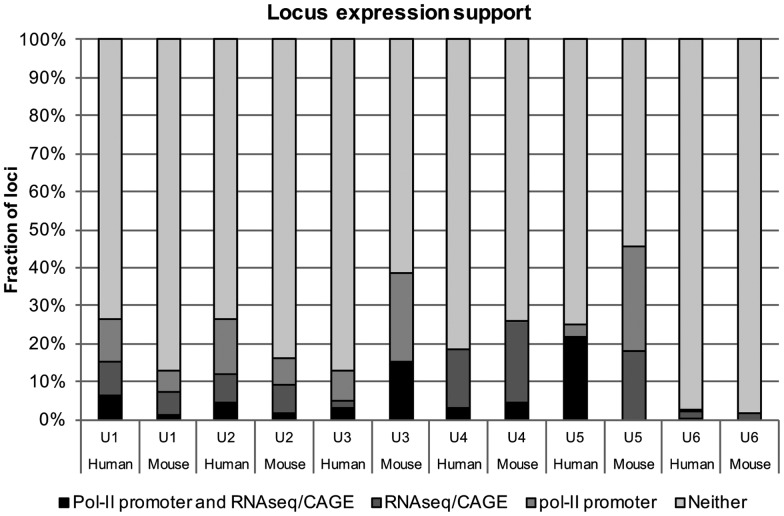
Evidence for locus transcription. We used two independent measures to determine potential expression of annotated URNA loci in human and mouse—the presence of a predicted upstream pol-II promoter element (≤500 bp) and signals from RNA-seq data and/or CAGE (see Materials and Methods). The data suggest that a minor fraction of loci for each family has support from both lines of evidence (“Pol-II Promoter and RNA-seq/CAGE”), whereas a sizable number at least have a putative promoter (“pol-II promoter”) suggesting that a locus may be transcriptionally active but perhaps not under the observed conditions. Another 5–15% of loci have mapped reads (“RNA-seq/CAGE”), but no nearby promoter candidate, which may hint at either another means for transcription or stochastic effects of read mapping against highly similar gene copies. Lastly, the majority of loci across families has no support for transcription whatsoever, strongly indicating that they are inactive retrogenes.